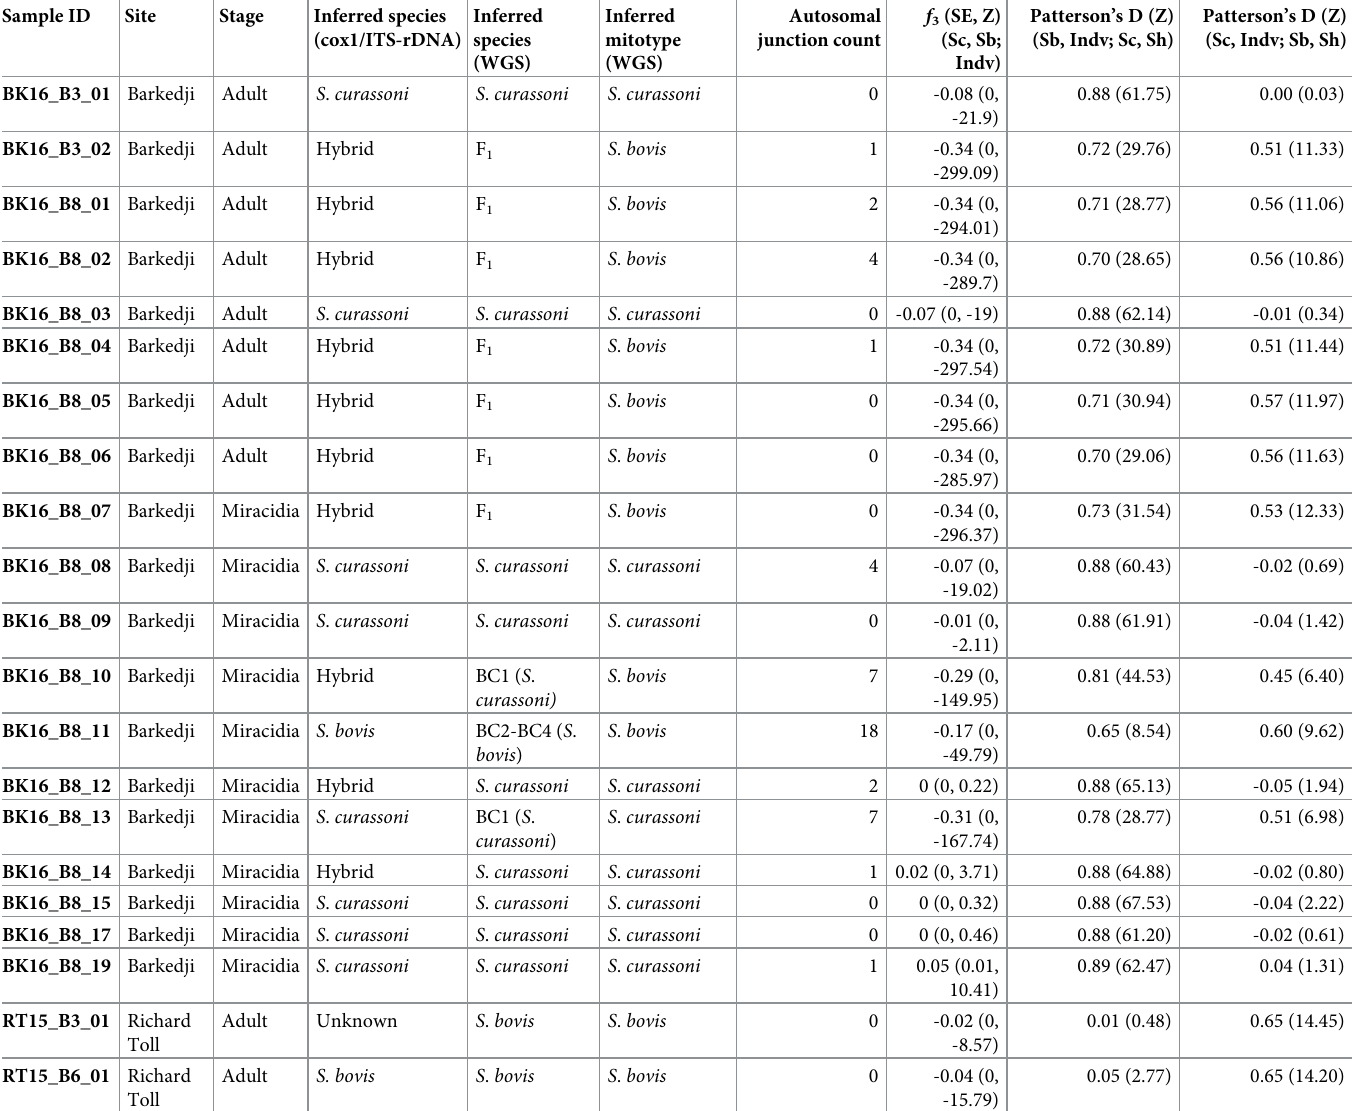
Table 3. Inferred species classifications and admixture